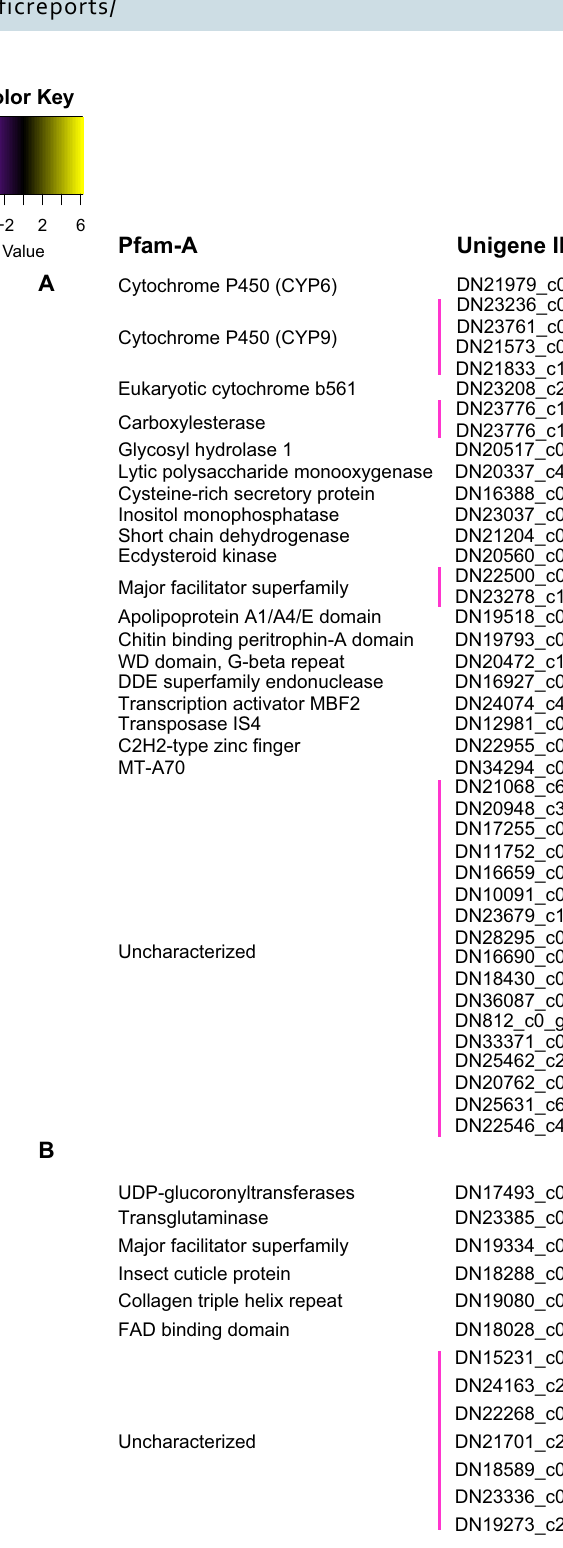
Figure 3. Heatmap of ( A ) up-regulated and ( B ) down-regulated unigenes in Dectes texanus larvae fed soybean compared to those fed sunflower and giant ragweed (GR). Each row represents an individual unigene. Yellow and purple indicate high and low expression levels, respectively (Fold change > ± 1.5, False Discovery Rate < 0.05). Pfam-A = Protein family-A domain; CYP = Cytochrome P450; CarE = Carboxylesterase; MFS = Major facilitator superfamily; WD = Tryptophan-aspartic acid dipeptide; DDE = Aspartic acid- Aspartic acid-Glutamic acid motif; MBF2 = Multiprotein-bridging factor 2; IS4 = Insertion sequence 4 family; C2H2 = Cysteine- Cysteine -Histidine- Histidine motif; MT = Methyl-transferase; UGT = ; UDP-glucuronosyl- transferase; FAD = Flavin adenine